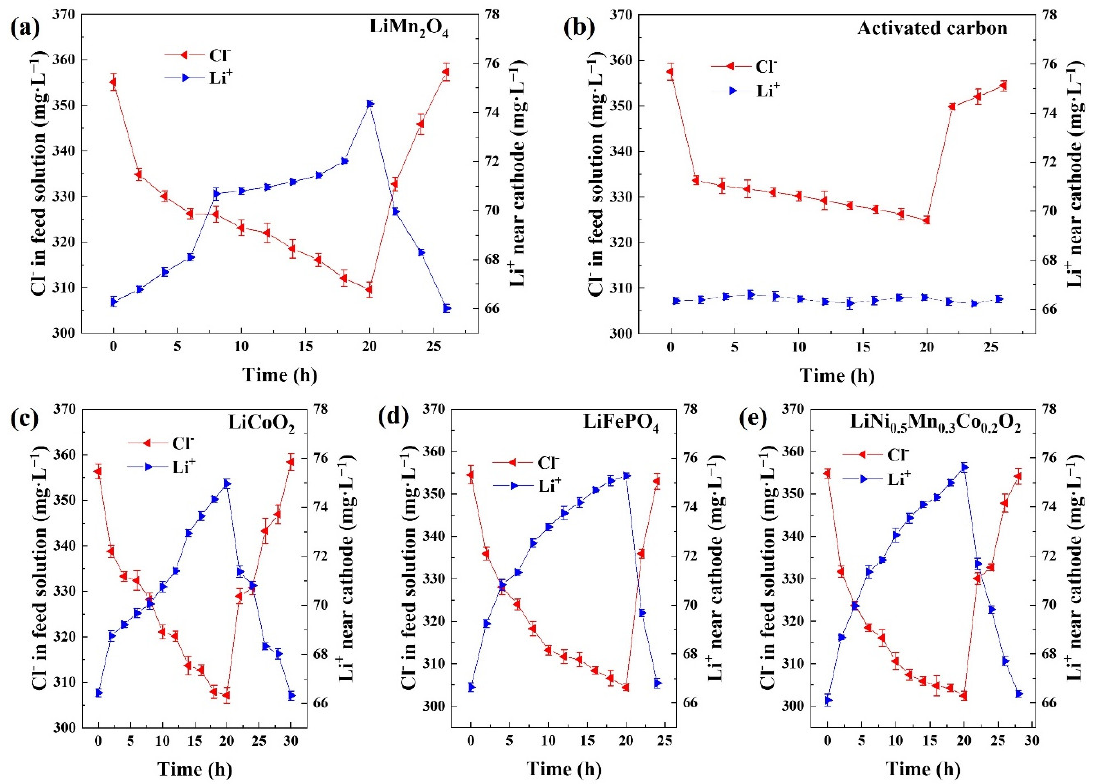
Figure 3. ( a – e ) The concentration variations of chloride ions in the feed solution and lithium ions in the LiCl solution during CDI desalination with different cathodes (voltage: 1.0 V, initial salt concentration: 10 mM).